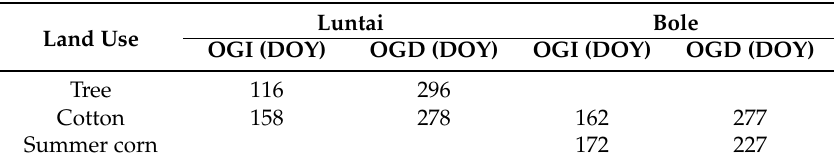
Figure 9. Phenology for different land cover types extracted from actual MODIS NDVI data in ( a ) Bole and ( b ) Luntai. Table 10. The OGI and OGD for each land use type extracted by MODIS NDVI data in Luntai and Bole. Land Use